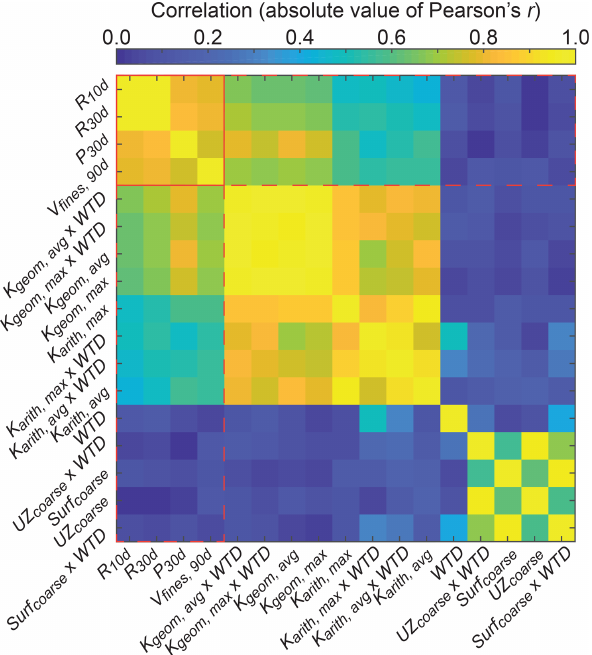
Figure 5. Correlations (absolute value of Pearson’s r ) for all com- binations of site characteristics and model outputs. Correlations among site characteristics are bounded by a solid red box, and corre- lations between site characteristics and model outputs are bounded by a dashed red box.